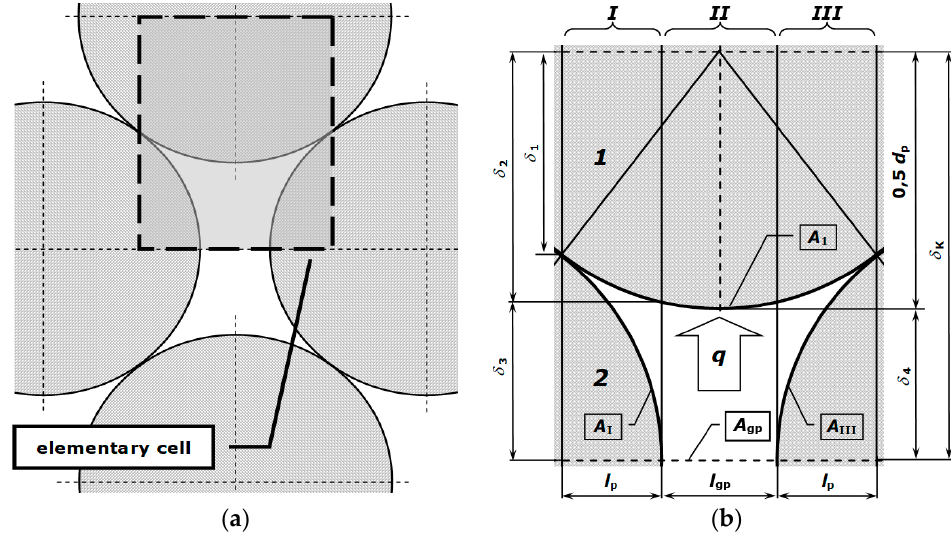
Figure 6. The elementary cell: ( a ) part of the considered charge; ( b ) elementary cell used for thermal resistance analysis.